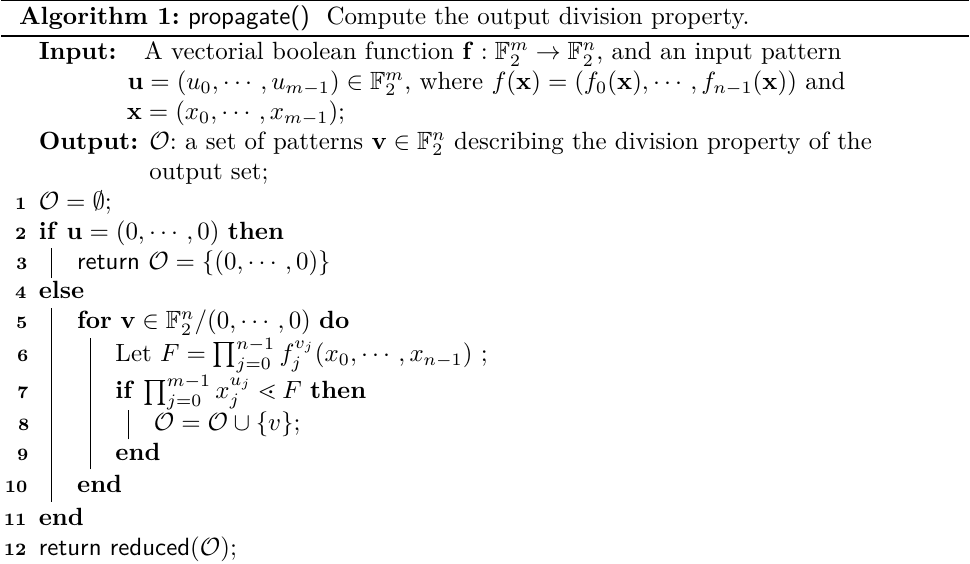
Algorithm 1: propagate() Compute the output division